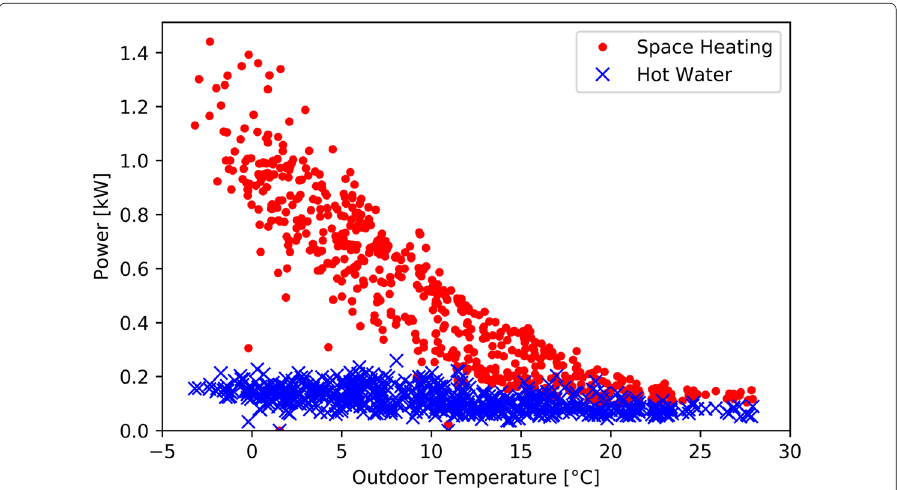
for every day between October 2018 and May 2020 and illustrates this